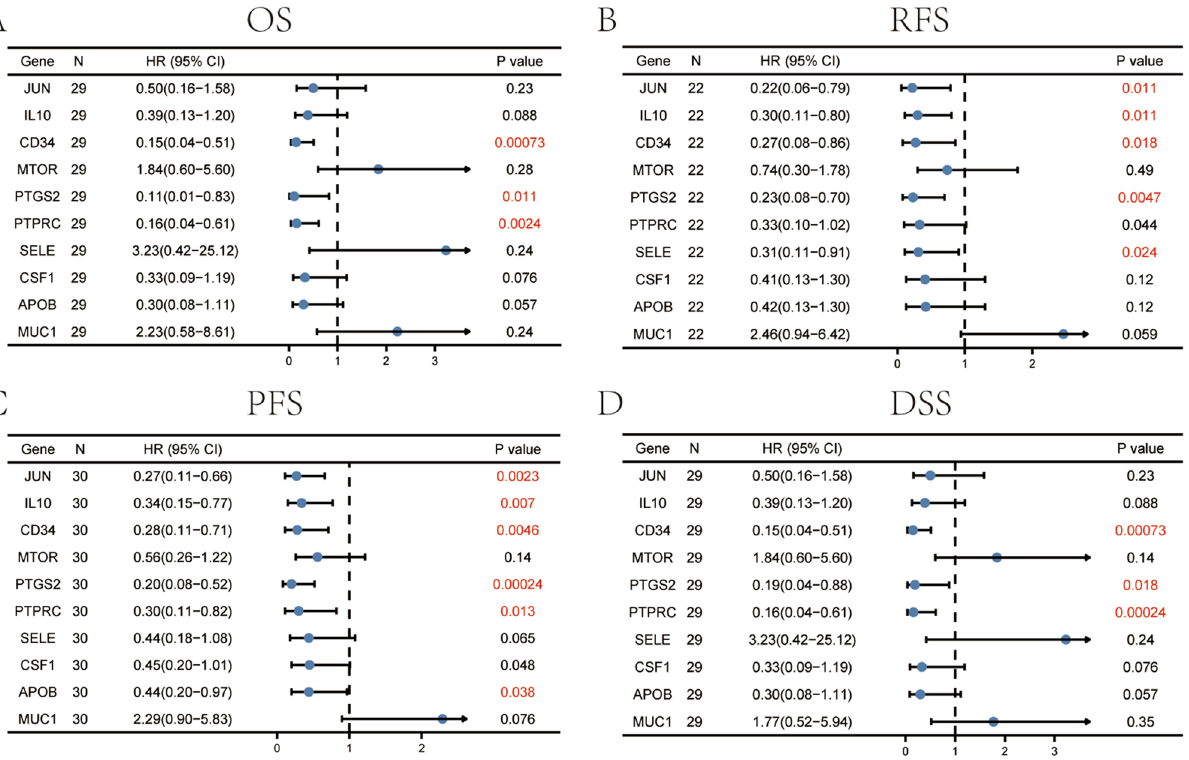
Figure 8. The prognostic value of ten hub genes in HCC patients who received sorafenib treatment. ( A ) OS analyses, ( B ) RFS analyses, ( C ) PFS analyses, ( D ) DSS